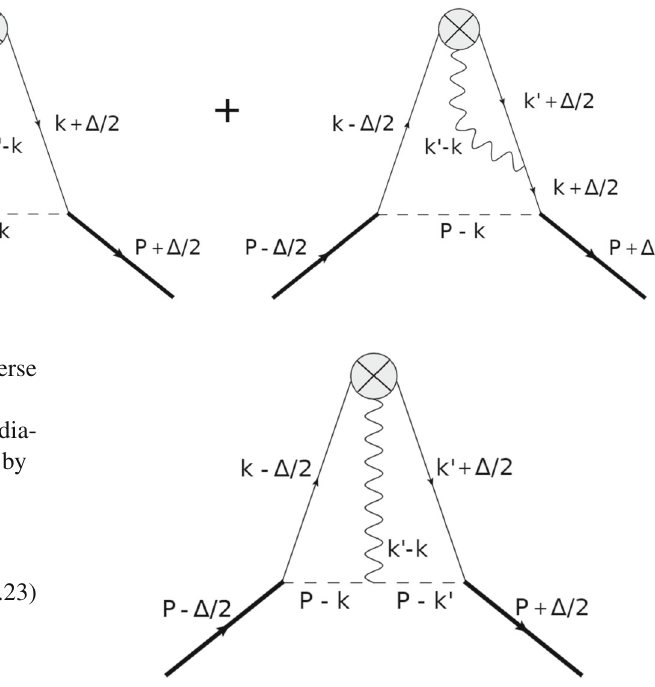
Fig. 8 Diagram with the scalar diquark acting as the spectator system while a photon is attached to it